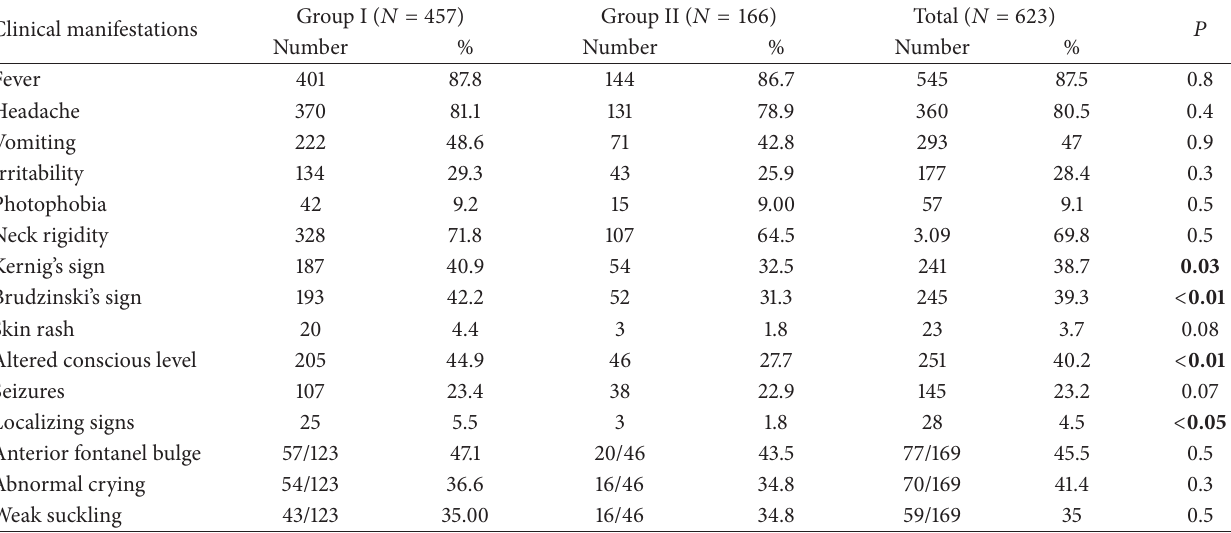
Table 2: Underlying and associated conditions in bacterial and nonbacterial meningitis groups in the studied population.